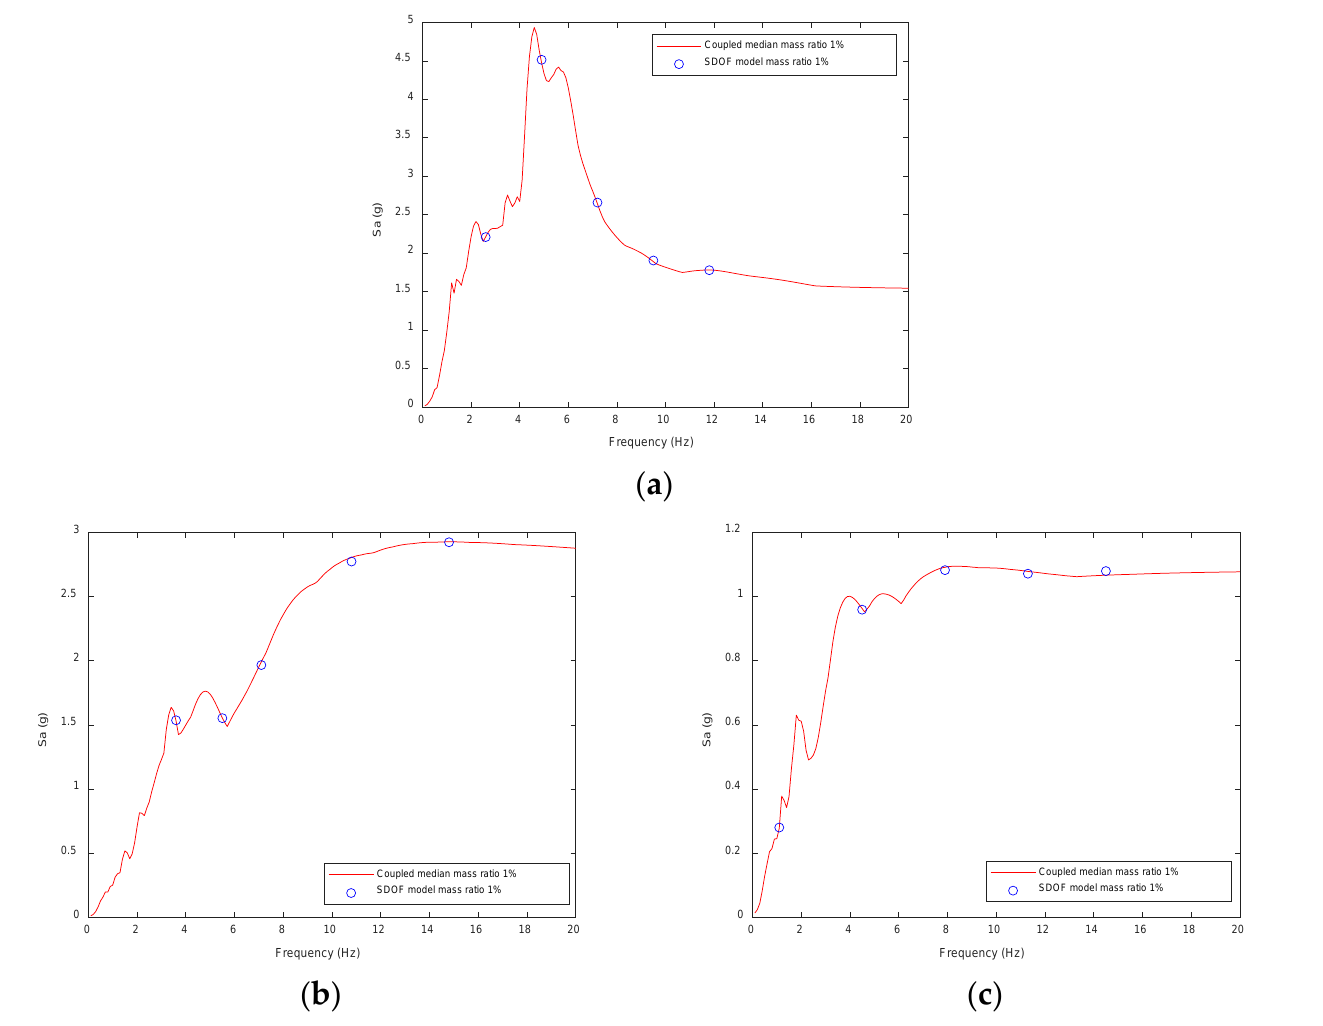
Figure 10. Acceleration response of the oscillator from the coupled analysis and ISRS based on substructure technique: ( a ) H2-direction at equipment location 1; ( b ) V-direction at equipment location 1; ( c ) V-direction at equipment location 3.